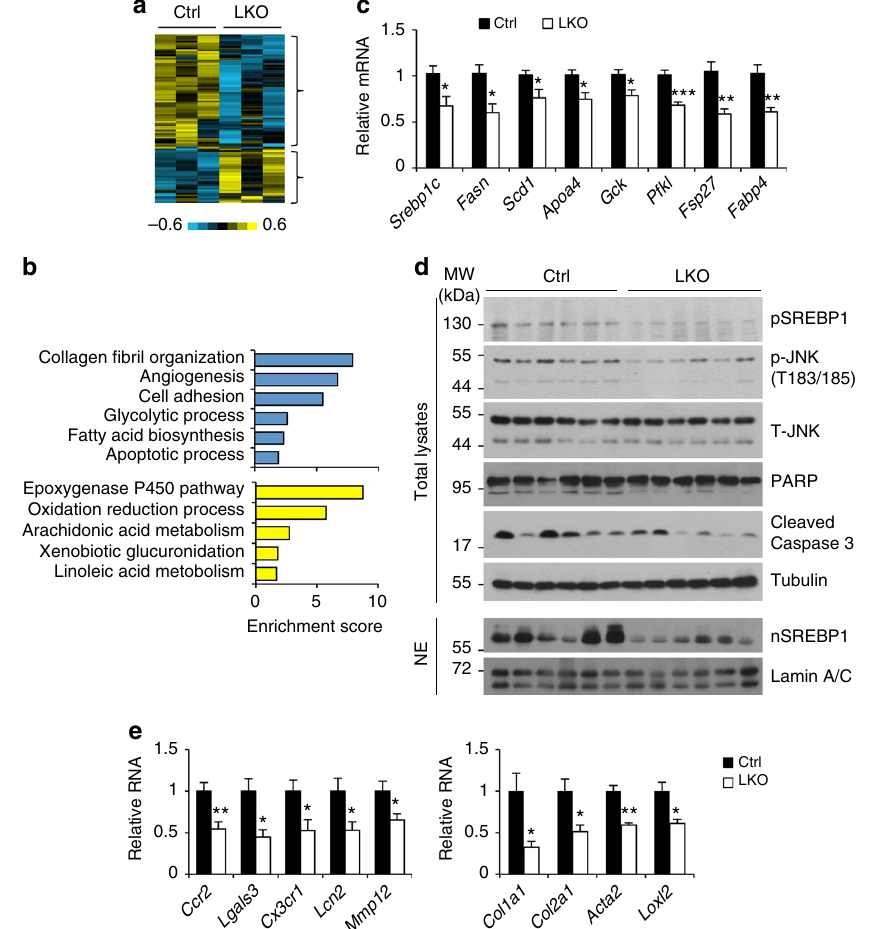
Fig. 7 Blnc1 inactivation suppresses the molecular signature of diet-induced NASH. a Heat map representation of upregulated and downregulated genes identi fi ed in RNAseq analysis of the livers from NASH-fed mice. b Enrichment score for downregulated (blue) and upregulated (yellow) genes. c qPCR analysis of hepatic genes involved in lipid metabolism from ctrl ( fi lled, n = 6) and LKO (open, n = 6) mice fed NASH diet for 24 weeks. d Immunoblots of total liver lysates and liver nuclear extracts from NASH-fed mice. e qPCR analysis of hepatic genes involved in in fl ammation and fi brosis. Data in ( c ) and ( e ) represent mean ± SEM. * p < 0.05, ** p < 0.01, *** p < 0.01; ctrl vs. LKO, two-tailed unpaired Student ’ s t